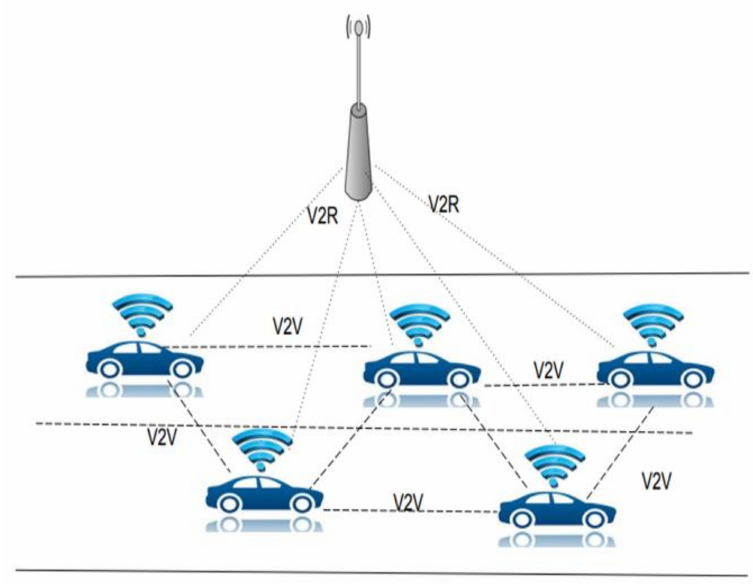
Figure 1. Structure of VANET.